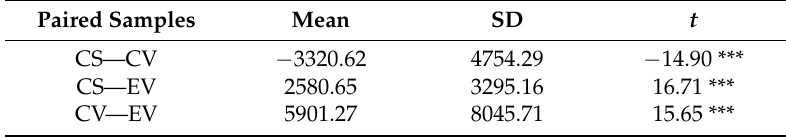
Table 10. Results of paired-sample t -test for the truncated Poisson model (TPOIS) model. Paired Samples Mean